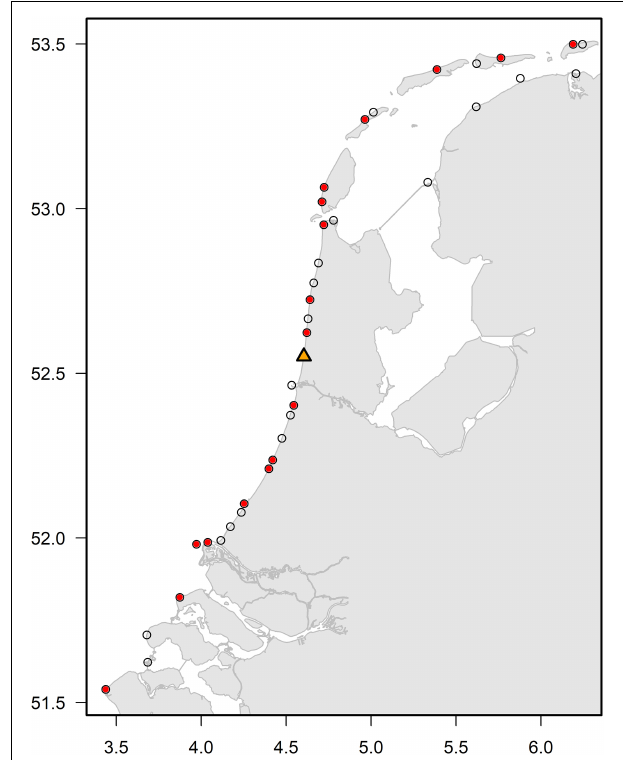
FIGURE 1 | Location of coastal observation points in The Netherlands (black open circles) and those with sufficient data (red circles, observation sites with > 5,000 h of effort) to be included in the analysis. The orange triangle represents the observation site “Castricum aan Zee” (site id = 527) which was used as reference site for further